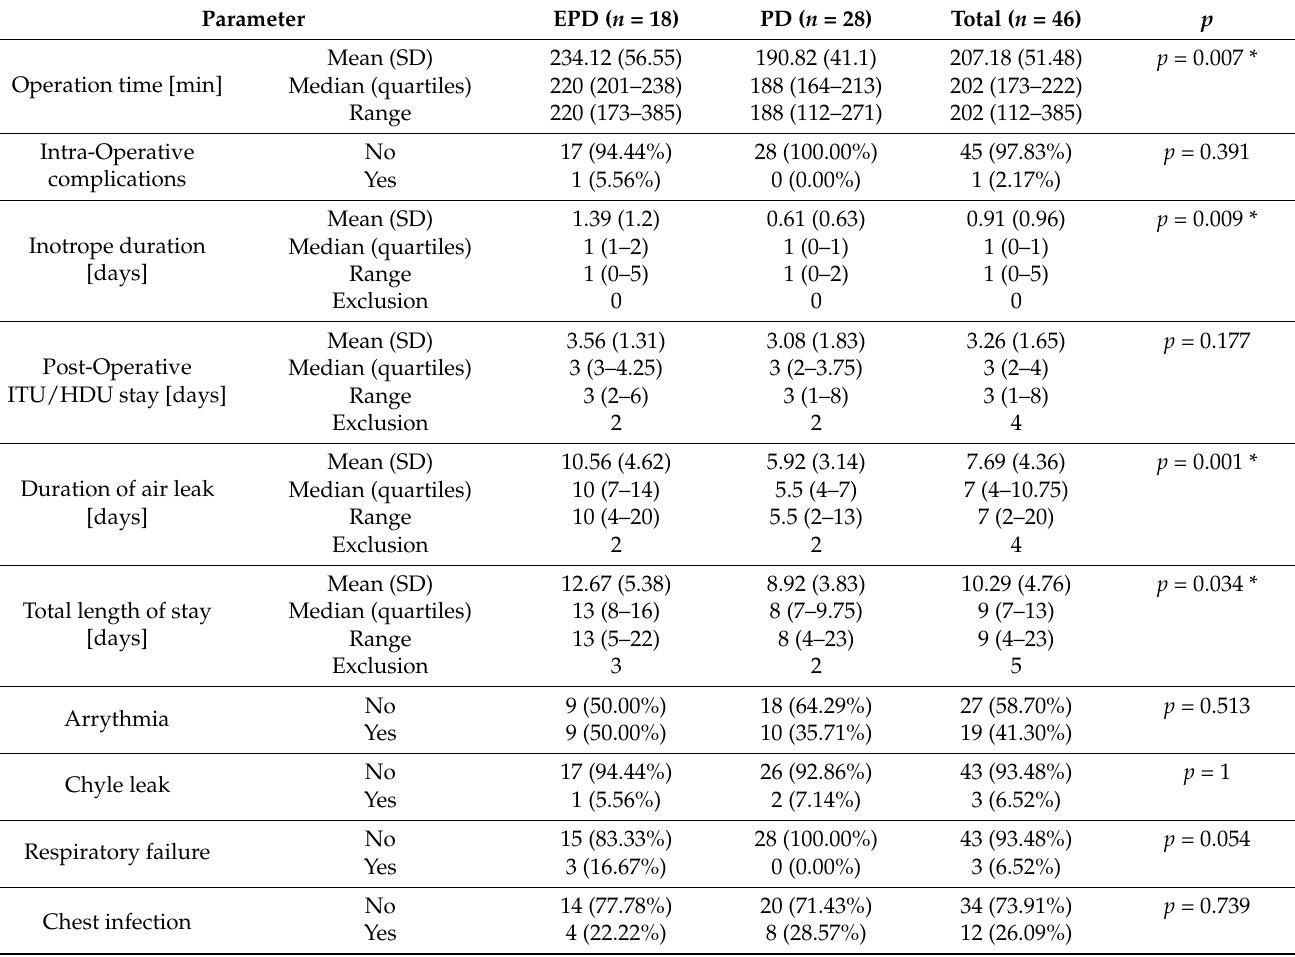
Table 3. Perioperative Clinical Outcome. EPD indicates extended pleurectomy/decortication; PD, pleurectomy/decortication; ITU, intensive therapy unit; HDU, high dependency unit; SD, stan- dard